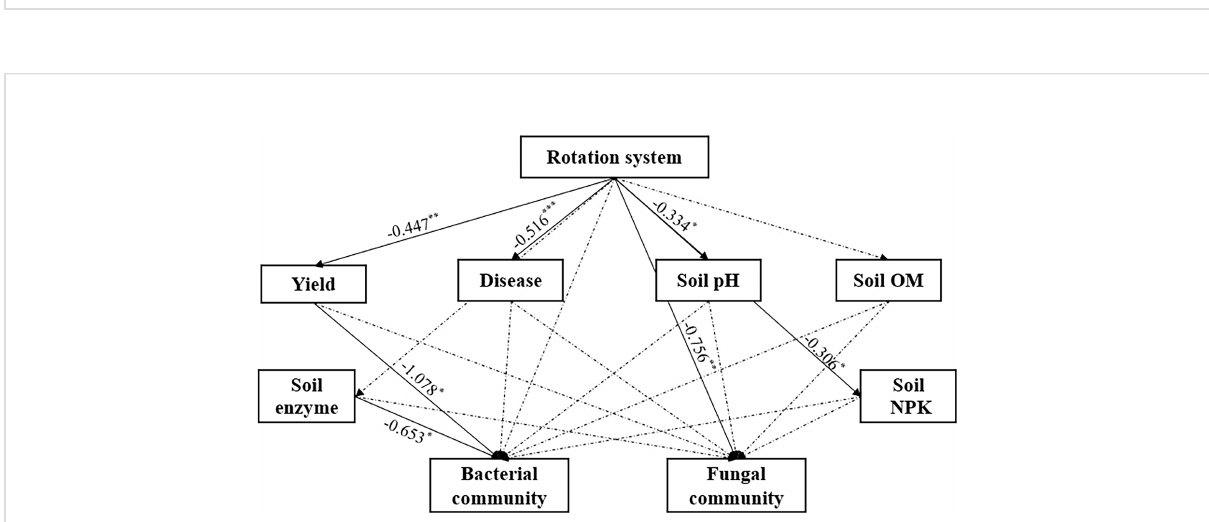
FIGURE 7 Partial least squares structural equation model (PLS-SEM) graph. Solid line and Dash line with arrow indicate signi fi cant and insigni fi cant effect between the two measurements, respectively. Bacterial community and fungal community consisted of the top 20 bacterial and fungal genera, respectively. The numbers next to the line indicate the path coef fi cient. * P < 0.05 , ** P < 0.01 and *** P < 0.001 indicate signi fi cant effect between the two